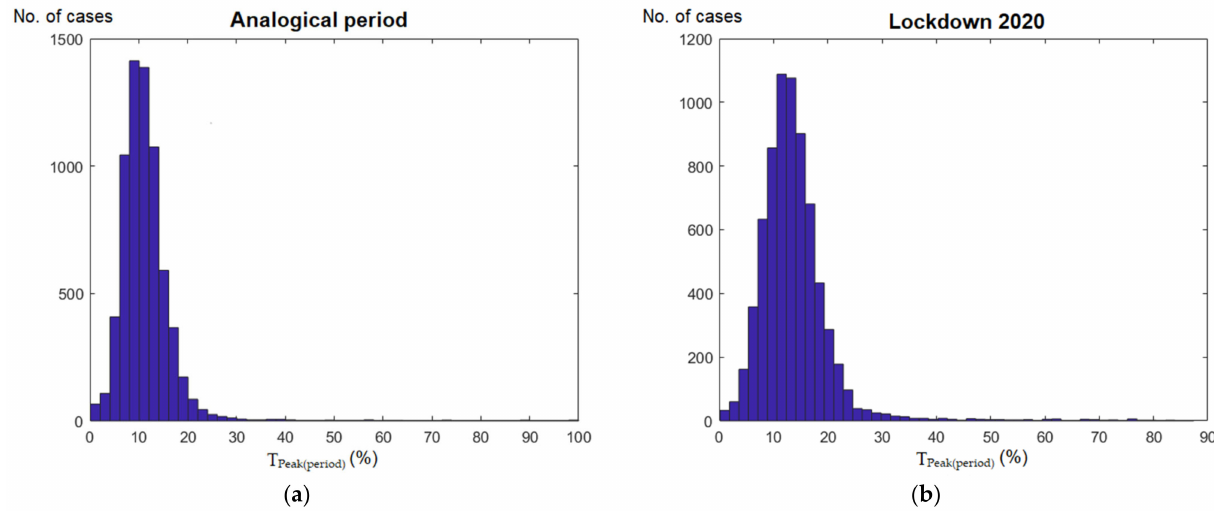
Figure 9. Histograms of peak power duration, T Peak(period) values, over 815 h covering the same period as the lockdown of 2018 ( a ) and the 2020 lockdown ( b ), in